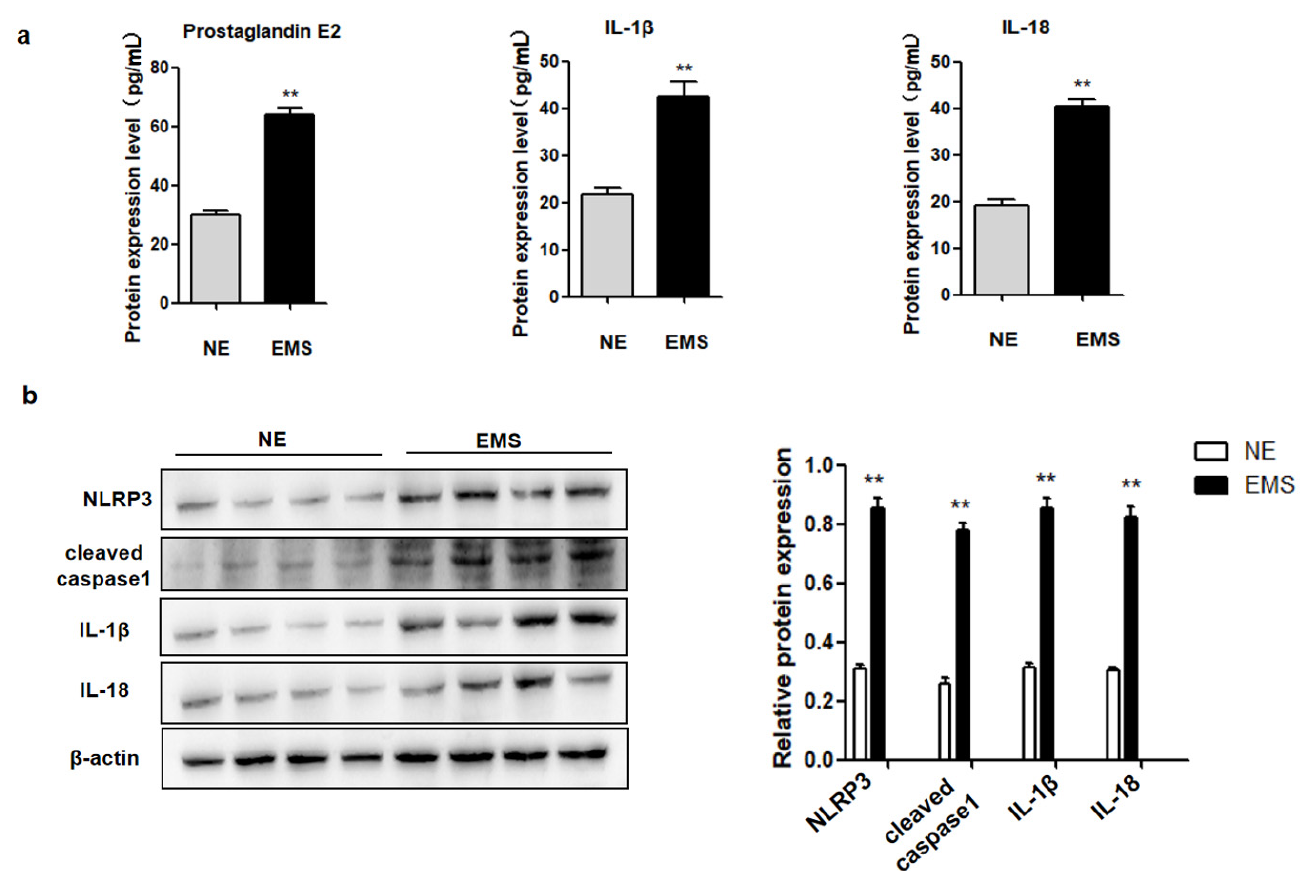
Figure 1. The expression of PGE2 and pyroptosis related proteins (NLRP3, cleaved caspase-1, IL-1 β and IL-18) were increased in ectopic ovarian endometriosis cyst patients. ( a ) The expression of PEG2, IL-1 β and IL-18 in serum of ectopic ovarian endometriosis cyst (EMS) and in the normal endometrium (NE) were detected by ELISA; ( b ) Pyroptosis related proteins (NLRP3, cleaved caspase-1, IL-1 β and IL-18) protein expression were measured by Western blot analysis in NE and EMS. The data are expressed as means ± SEM. ** p < 0.05 by two-tailed Student’s t test.